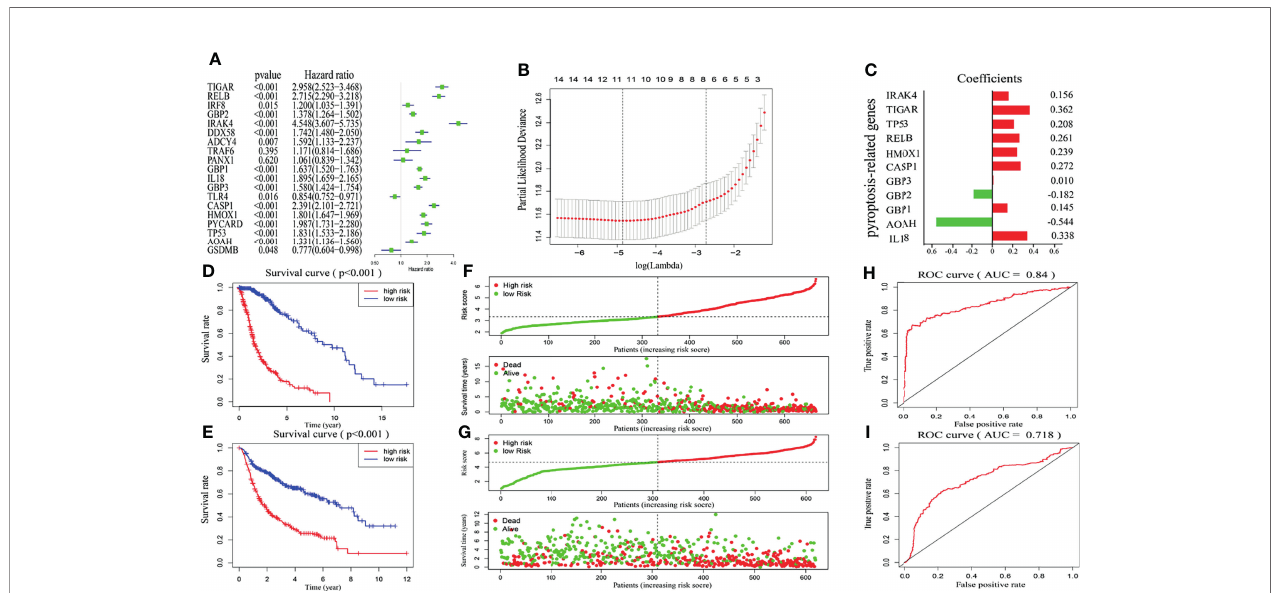
FIGURE 3 | Construction and validation of risk model. (A) Univariate analysis presents the hazard ratios and P-value of nineteen pyroptosis-related genes by the forest plot. (B) Cross-validation for adjusting parameter choice in LASSO regression analysis. (C) The risk signature containing eleven pyroptosis-related genes and the corresponding coef fi cients. (D, E) Kaplan – Meier survival curves for glioma patients from the TCGA (D) and CGGA (E) datasets in high- and low-risk groups. (F, G) Surveying the risk model in TCGA (F) and CGGA (G) datasets: distribution and survival status in glioma patients between the two risk groups. (H, I) The predictive ef fi ciency of the risk score is presented by the ROC curves in both TCGA (H) and CGGA (I)